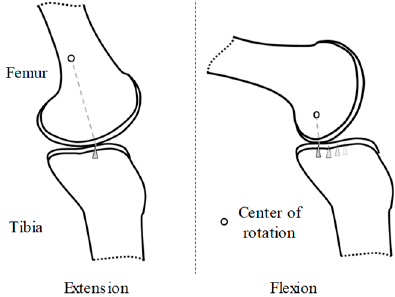
Figure 1. Movement of the femur on the tibia plane. The contact point and center of rotation change according to the movement of the knee.